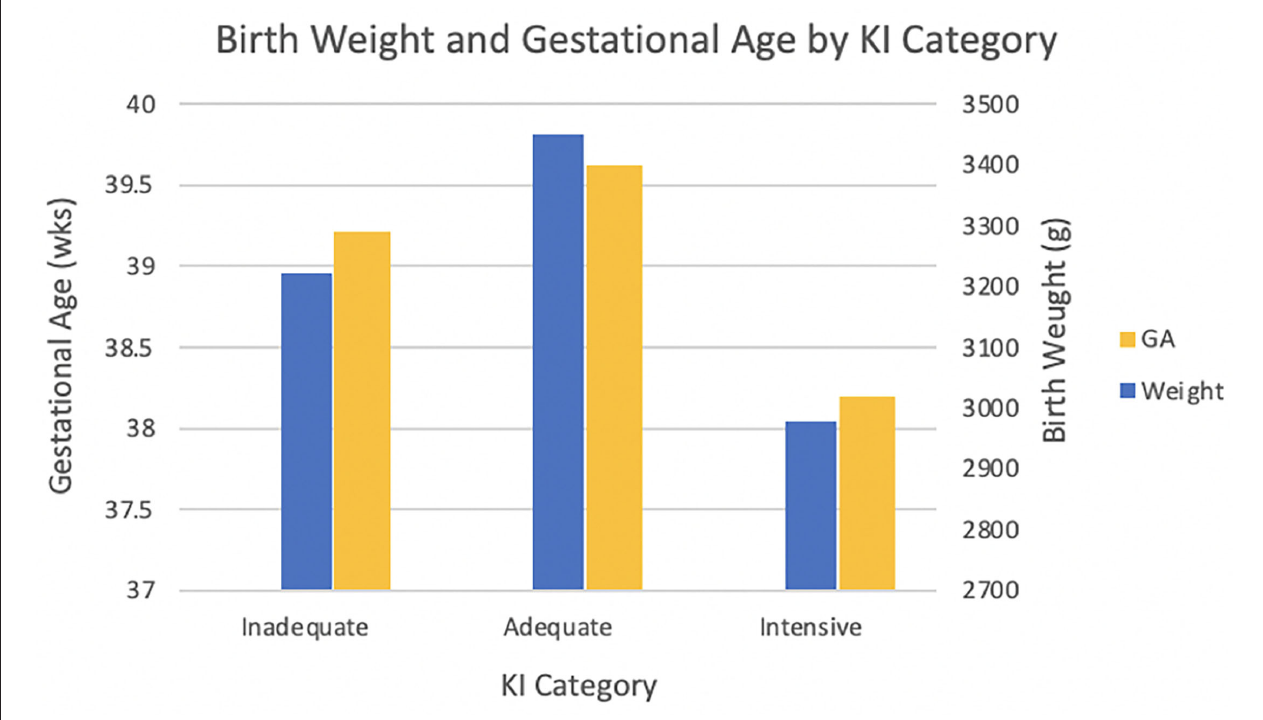
FIGURE 1 | Differences in birth weight and gestational age based on level prenatal care. Adequate care babies ( M = 3448.78 ± 504.19g) had higher mean birthweight than Inadequate/Intermediate ( M = 3222.49 ± 467.96g) and Intensive care ( M = 2977.57 ± 718.11g) babies [ F (2, 288) = 11.57, p < 0.001]. The mean gestational age for Intensive care babies ( M = 38.19 ± 2.84 wks) was earlier than that for Inadequate/Intermediate ( M = 39.21 ± 1.17 wks) and Adequate care ( M = 39.62 ± 1.36 wks) babies [ F (2, 288) = 10.31, p <